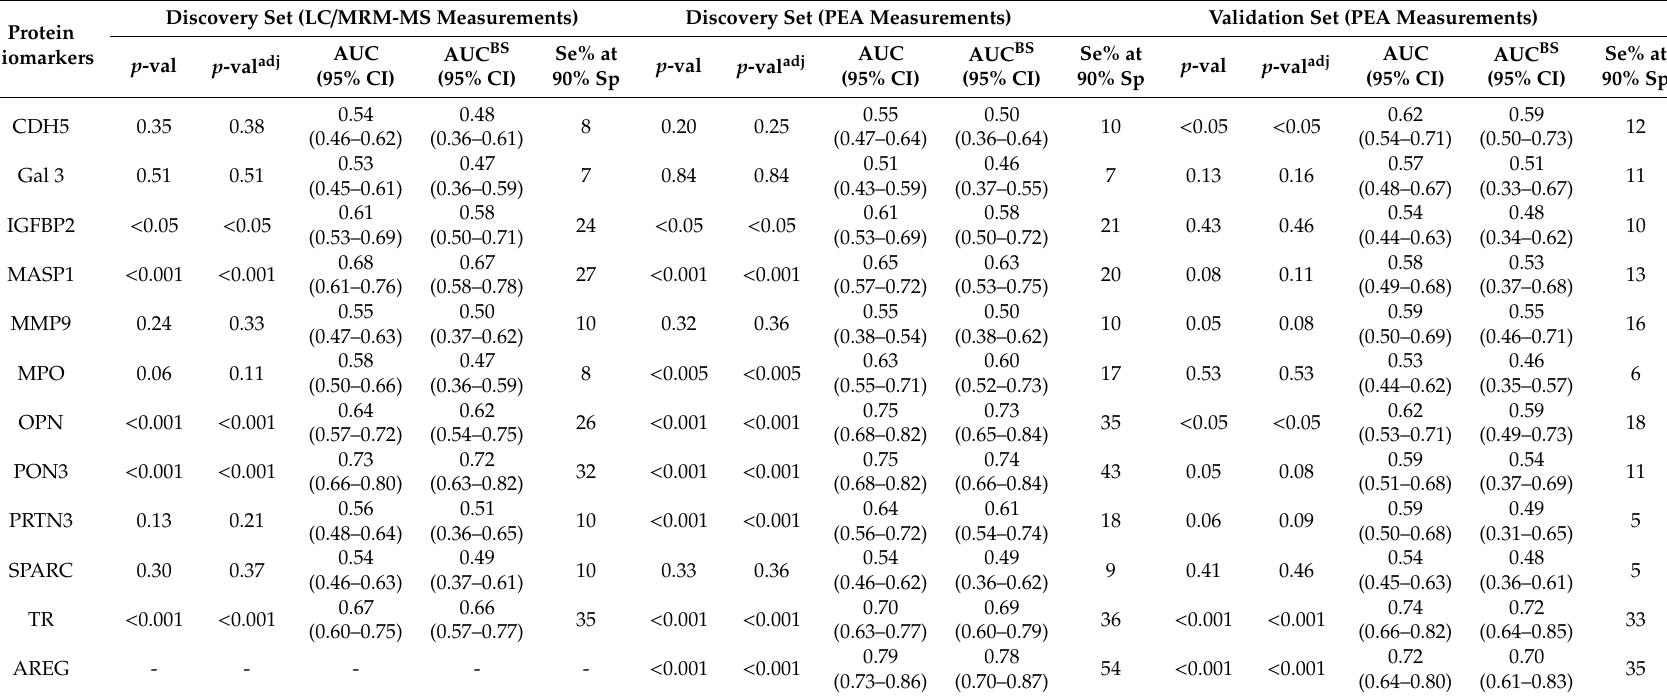
Table 2. Diagnostic performance of individual protein biomarkers for detecting